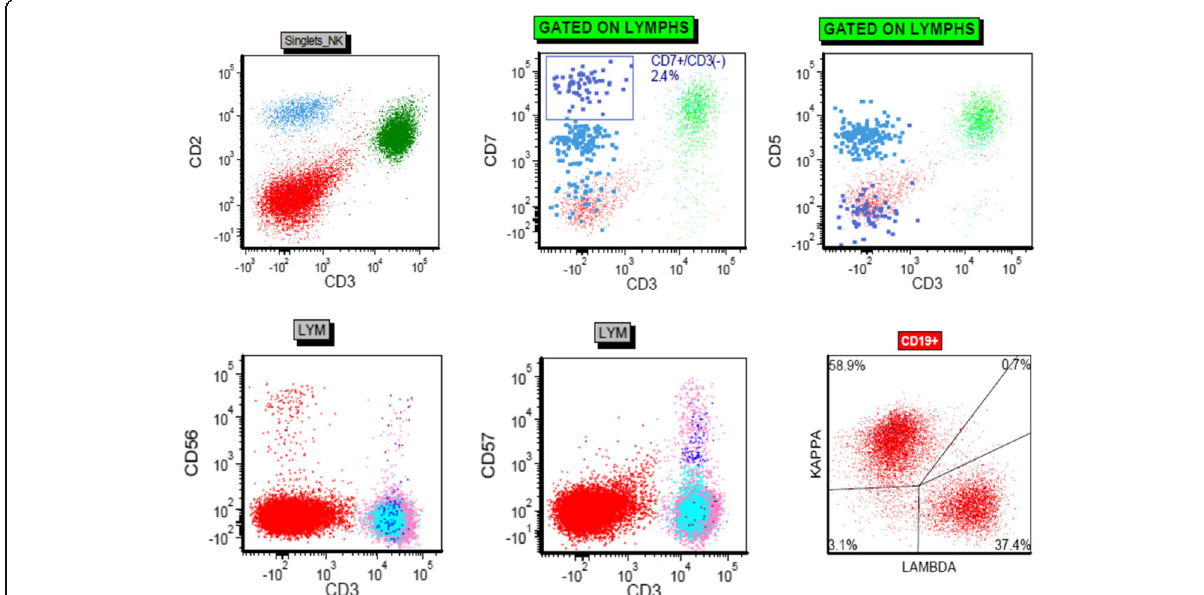
Fig. 3 Flow cytometric analysis of representative tissue from the nasal biopsy. The aberrant lymphoid population (light blue) is surface CD3-, CD2 +, CD5(dim)+, CD7(dim)+, CD56- and CD57- . Also present are normal CD3+ T cells (green) without significant loss of pan T-cell antigens (green) as well as normal CD3- and CD7+ NK cells (dark blue) and polyclonal B-cells (red)